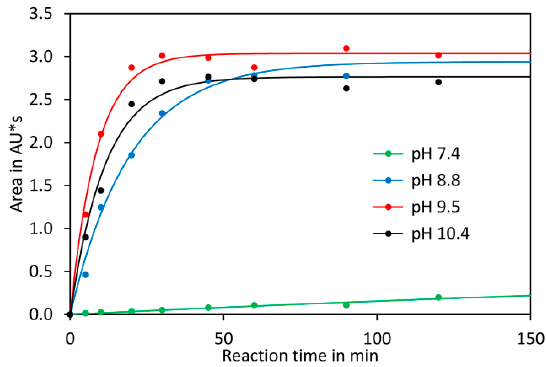
Figure A1. Kinetics of derivatisation at different pH values. Aspartic acid was derivatised with 30 mM DNFB in N -methylmorpholine/acetic acid buffer pH 7.4, sodium hydrogen carbonate/sodium